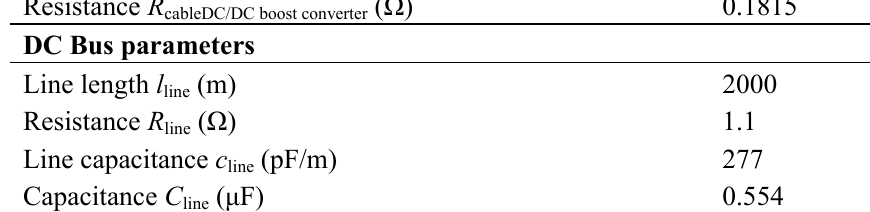
4.2. Two DC/DC Boost Converters of 40 kWp Each, Interfaced to the 2 km DC Line through 150 m